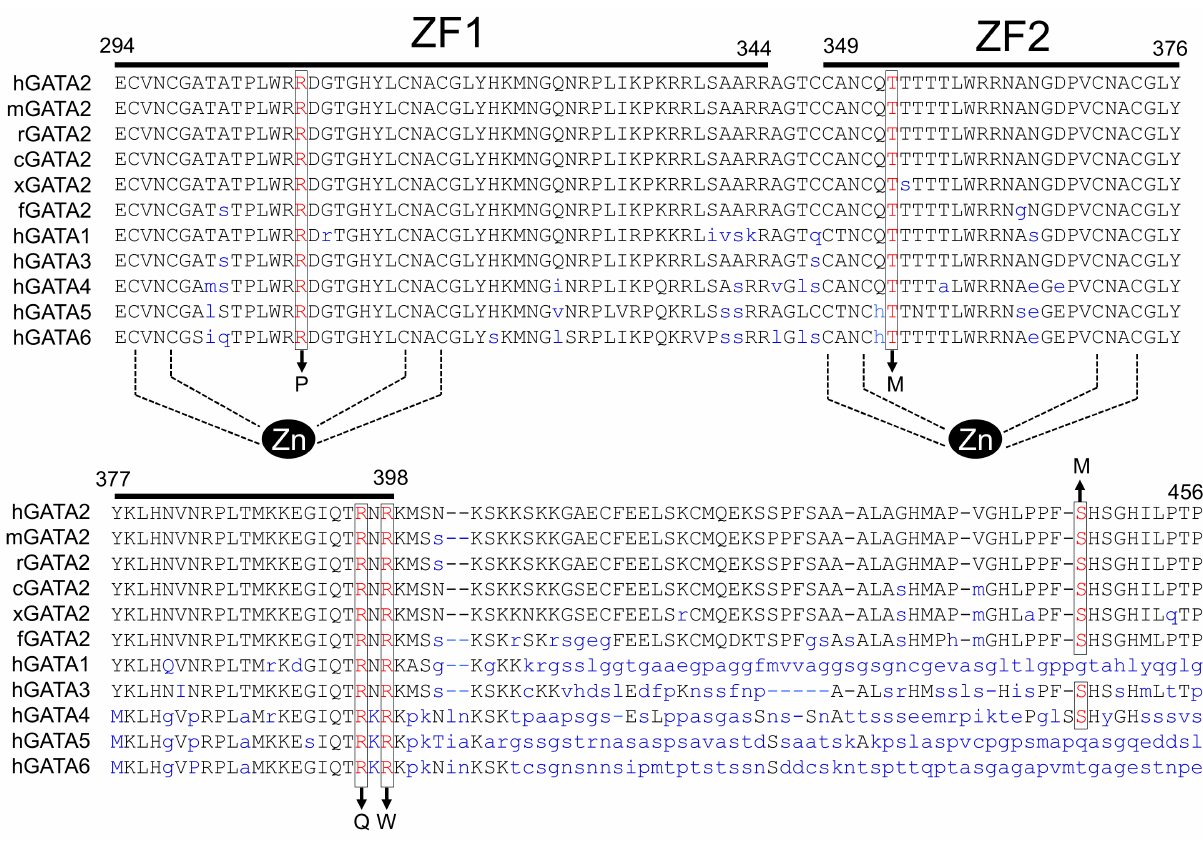
Figure 6. Amino acid sequences of the regions around the zinc (zn) fingers of the various GATA proteins. The amino acid sequences were retrieved from the National Center for Biotechnology Information database. Amino acid positions mutated in this study are indicated by boxes. The gene accession numbers for human GATA2 (hGATA2), mouse GATA2 (mGATA2), rat GATA2 (rGATA2), chicken ( Gallus gallus ) GATA2 (cGATA2), frog ( Xenopus laevis ) GATA2 (xGATA2), and fish ( Danio rerio ) GATA2 (fGATA2) are M68891, NM_008090, AY032734, NM_00100, XM_018256579, and NM_131233, respectively. The gene accession numbers for human GATA1, GATA3, GATA4, GATA5, and GATA6 are NM_002049, AY497006, AY740706, NM_080473, and NM_005257, respectively. ZF1, N-terminal zinc-finger domain; ZF2, C-terminal zinc finger